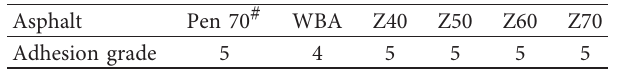
Table 6: Adhesion test results.